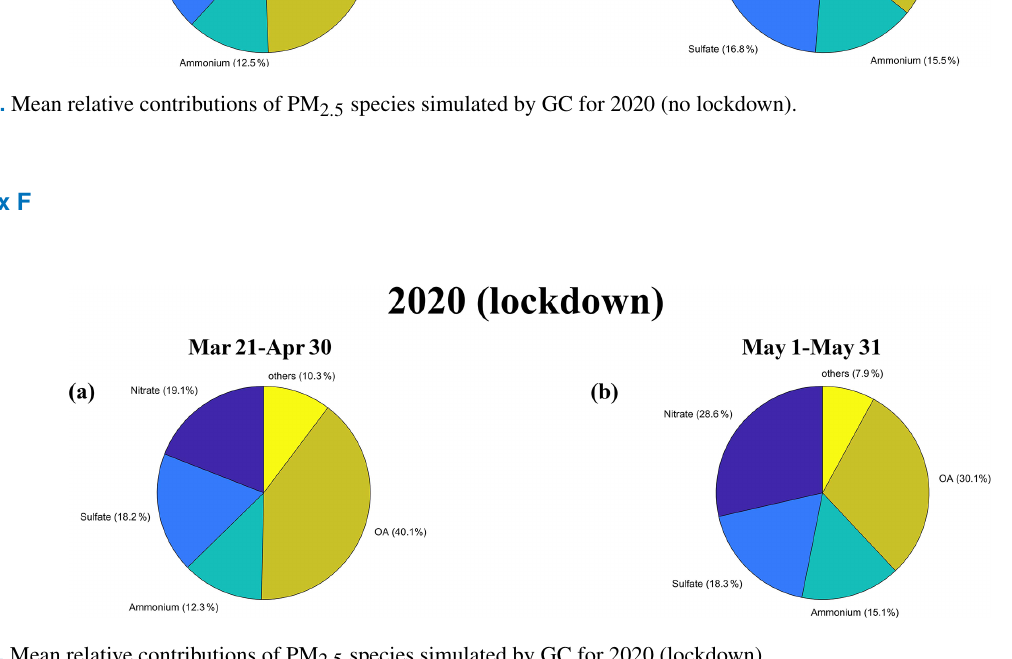
Figure F1. Mean relative contributions of PM 2 . 5 species simulated by GC for 2020 (lockdown).